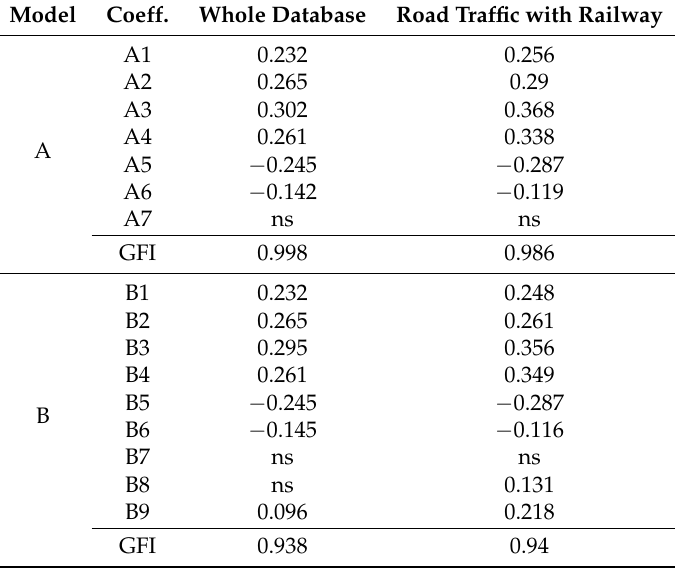
Table 7. Standardized coefficients used in models of the partial annoyance due to railway noise. Models are based on different samples of the French in situ survey database. Model